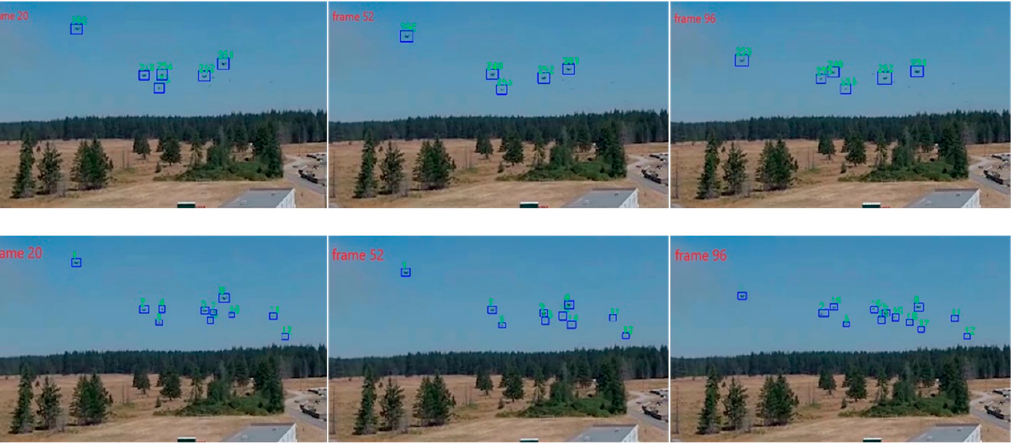
Figure 12. Tracking results of UAVSwarm − 46 (Top: ByteTrack; Bottom: GNMOT; 20th, 52nd, and 96th frames, from left to right).